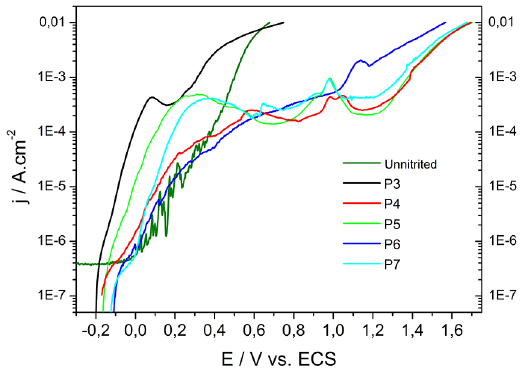
Figure 5. Potentiodynamic anodic polarization curves for samples nitrided at different pressures and unnitrided; in 3% NaCl aerated electrolytic solution.